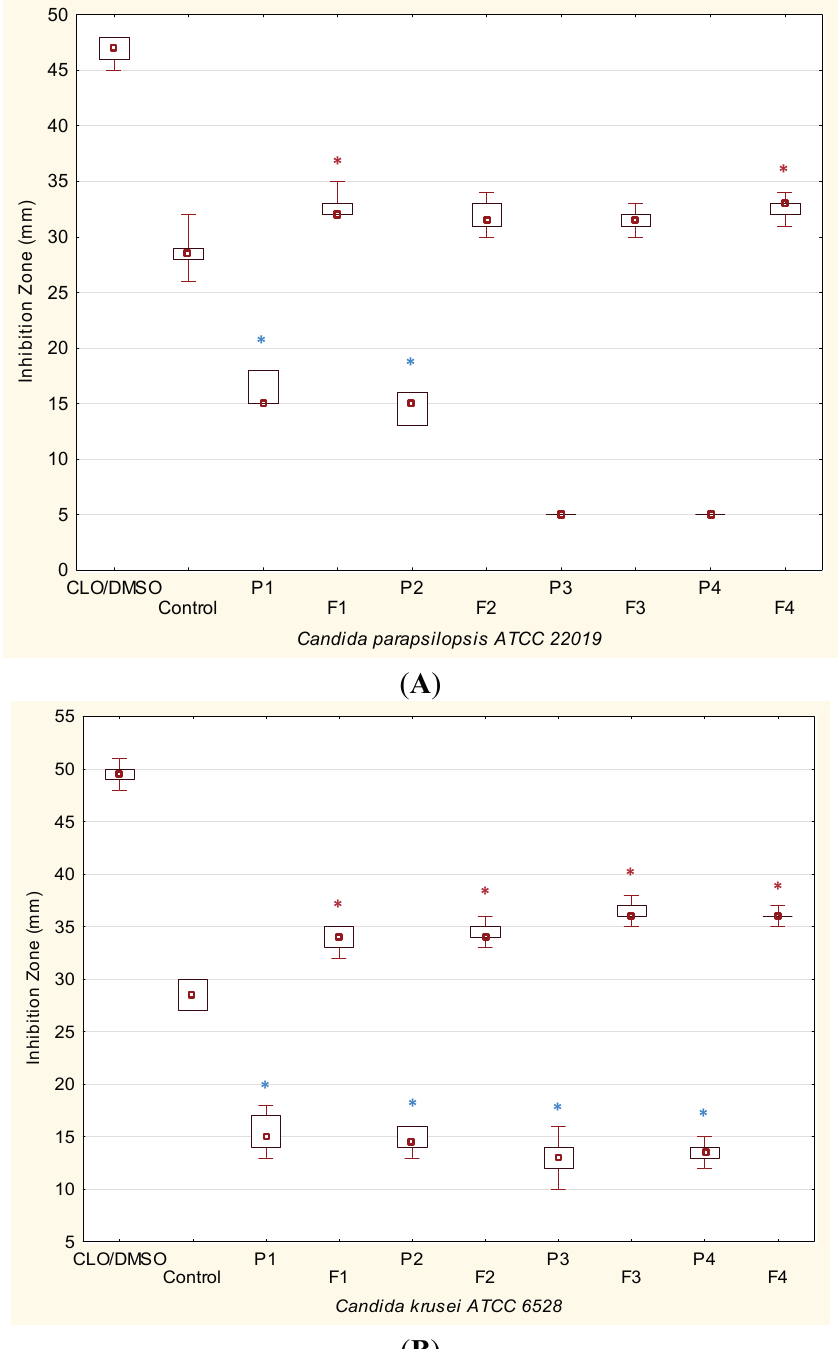
Figure 1. Box-plot graphs presenting antifungal activity of placebo hydrogels prepared with unmodified chitosan in concentration of 3% and 4% (P1, P2), with chitosan/ β -GP in concentration of 3% and 4% (P3, P4), hydrogels with clotrimazole (CLO) prepared with unmodified chitosan (F1, F2), hydrogels with CLO prepared with chitosan/ β -GP (F3, F4), reference standard (CLO/DMSO) and control (commercially available cream with CLO) against standard ( A , B ) or clinical strains of Candida sp. ( C , D ) ( n = 3). Boxes contain 50% of all values and whiskers represent the 25th and 75th percentiles. Significantly different ( p < 0.05) ratios are indicated by red asterisks (for hydrogels F1–F4) or by blue asterisks (for placebo